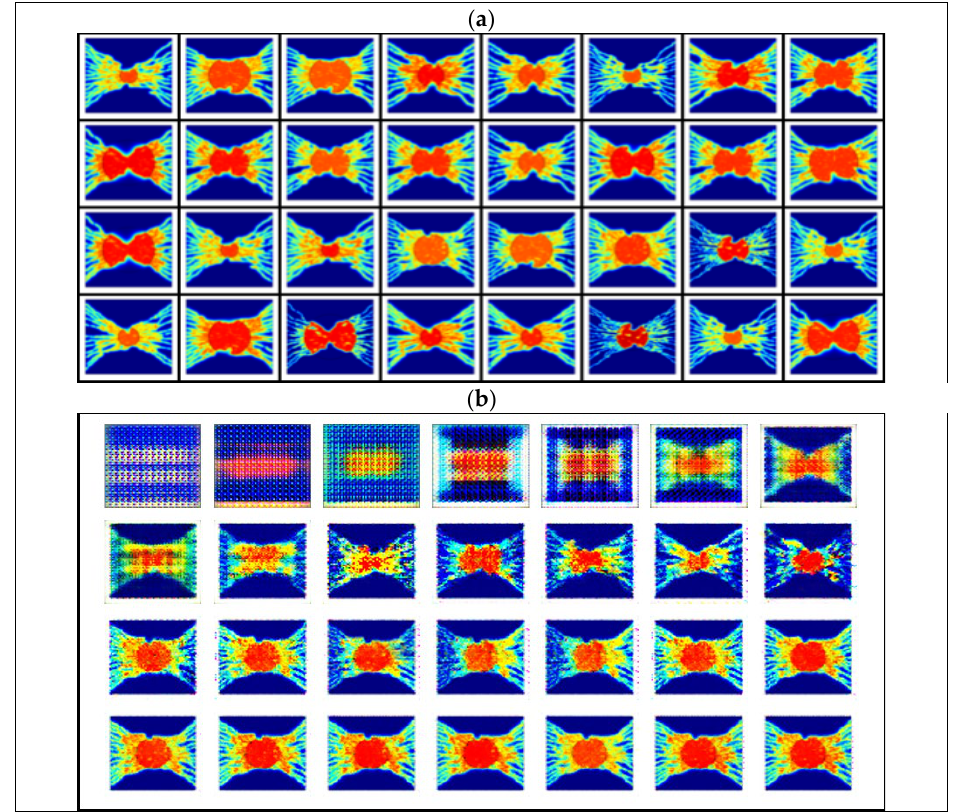
Figure 3. Thirty-two samples of input images are given to the DCGAN model and synthetically generated output images. ( a ) Sample of input images as training data set consisting of 1700 images of the spatiotemporal distribution of SUV at various times post 18F-FDG injection in 10 different tumor sizes, ranging from 1 to 3 cm diameter. ( b ) Visualization of the DCGAN output images after different epochs of training.